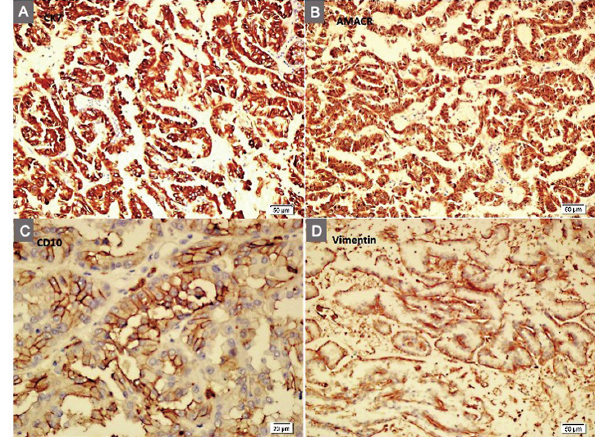
Fig. 3 ( A – D ) Tumoral cells expressed CK7 (x200), AMACR (x200), CD10 (x400), and vimentin